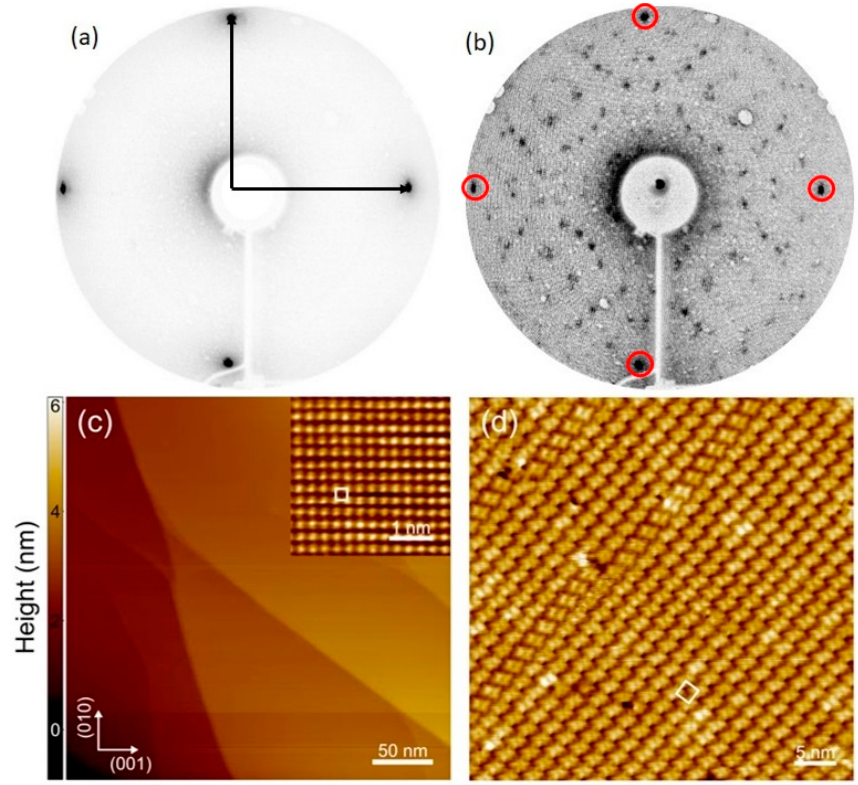
Figure 1. ( a ) LEED image acquired image on the Fe– p (1 × 1)O substrate. Black arrows indicate a basis of the reciprocal lattice. ( b ) LEED image acquired on the 1 ML NiTPP sample. The beam energy in both panels is 55 eV. Red circles indicate the spots due to the substrate. ( c ) Large scale STM image of the Fe– p (1 × 1)O substrate. Tunneling parameters are V = 1 V, I = 1 nA, image size is 300 × 300 nm 2 . The inset shows an atomically resolved image of the surface, acquired with V = 0.1 V, I = 10 nA tunneling parameters. The white square indicates the surface unit cell, with a lattice parameter of 0.29 nm. ( d ) The 32.6 × 32.6 nm 2 STM image acquired on the 1 ML NiTPP sample. The white square indicates the unit cell of the (5 × 5) R 37 reconstruction. Tunneling parameters are V = 2 V, I = 500 pA.